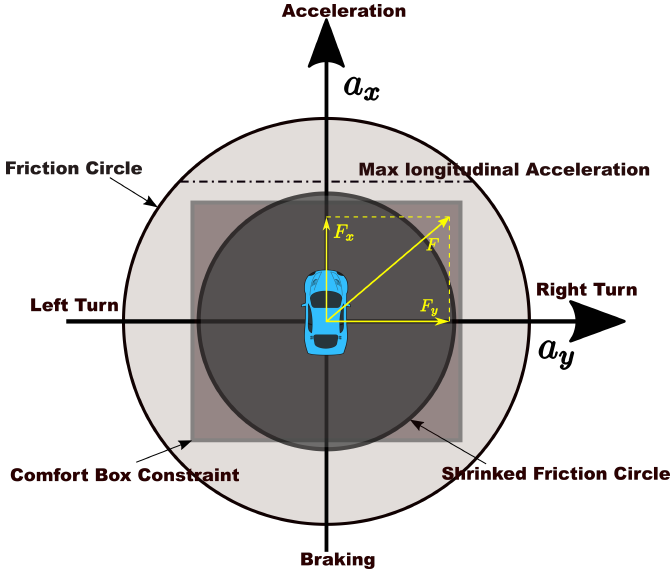
Figure 1. The comparison of solution spaces of the normal friction circle, the comfort box and the shrinked friction circle